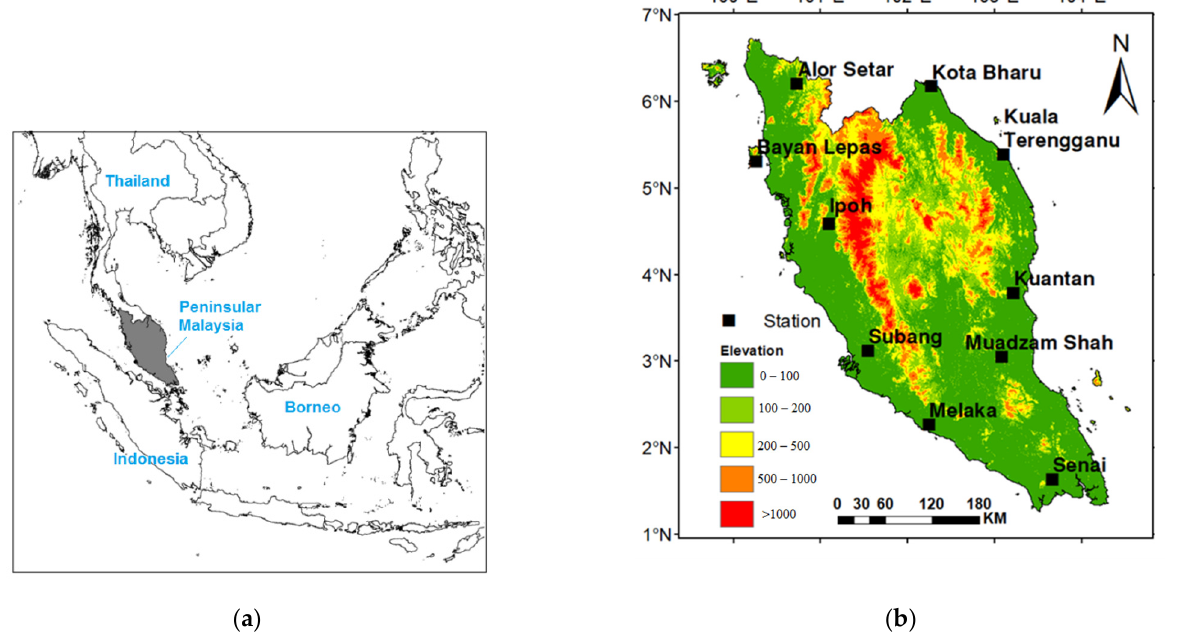
Figure 1 . ( a ) Location of peninsular Malaysia on the map of Southeast Asia; ( b ) Geographical position of peninsular Malaysia. The topography and location of the meteorological stations are also provided.